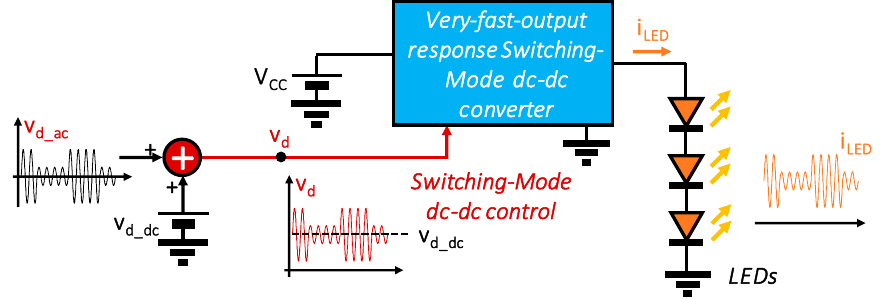
Figure 7. Very-fast-output Switching-Mode DC–DC converter for synthesizing the overall current passing through the LED string (VLC-LED driver). This scheme is valid for reproducing PBM, SCM and MCM schemes.